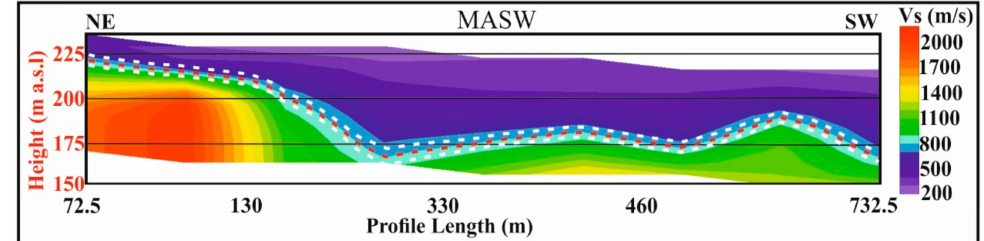
Figure 4. The result of the multi-channel analysis of surface waves (MASW). The red dashed line presents the geophysical boundary. The white dotted lines show the uncertainty of the result. The overall shape of the structure is similar to the result obtained in reflection imaging.